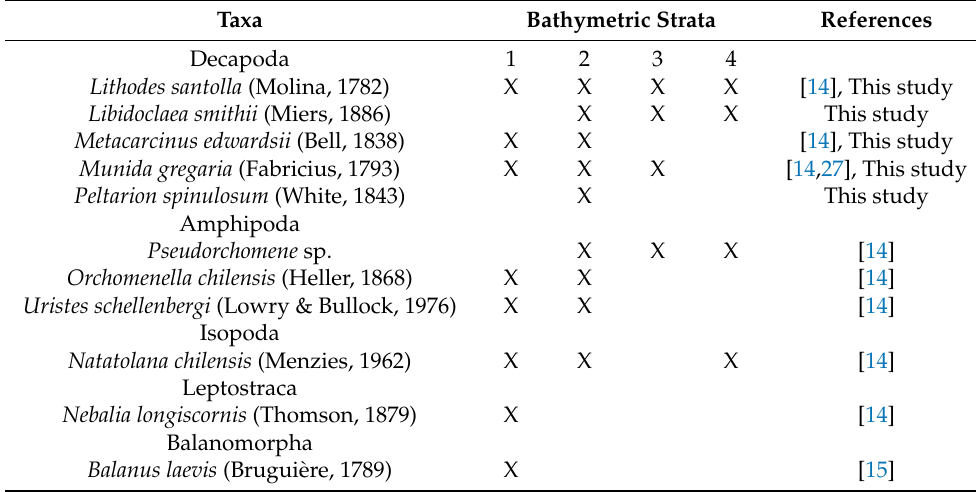
Table 5. Crustacean species recorded in different bathymetric strata (1 = 0–50 m; 2 = 51–100 m; 3 = 101–150 m; 4 = 151–200 m) in the Magdalena Sound, in central